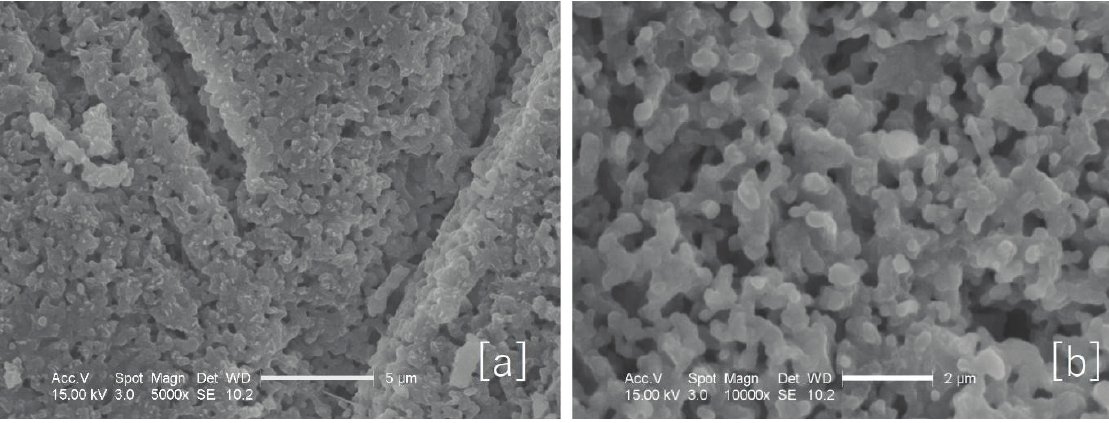
Fig. 6 – Surface of the SO grain after thermal activation at 373 K, BSE, magnification: a) 5000x, b) 10000x